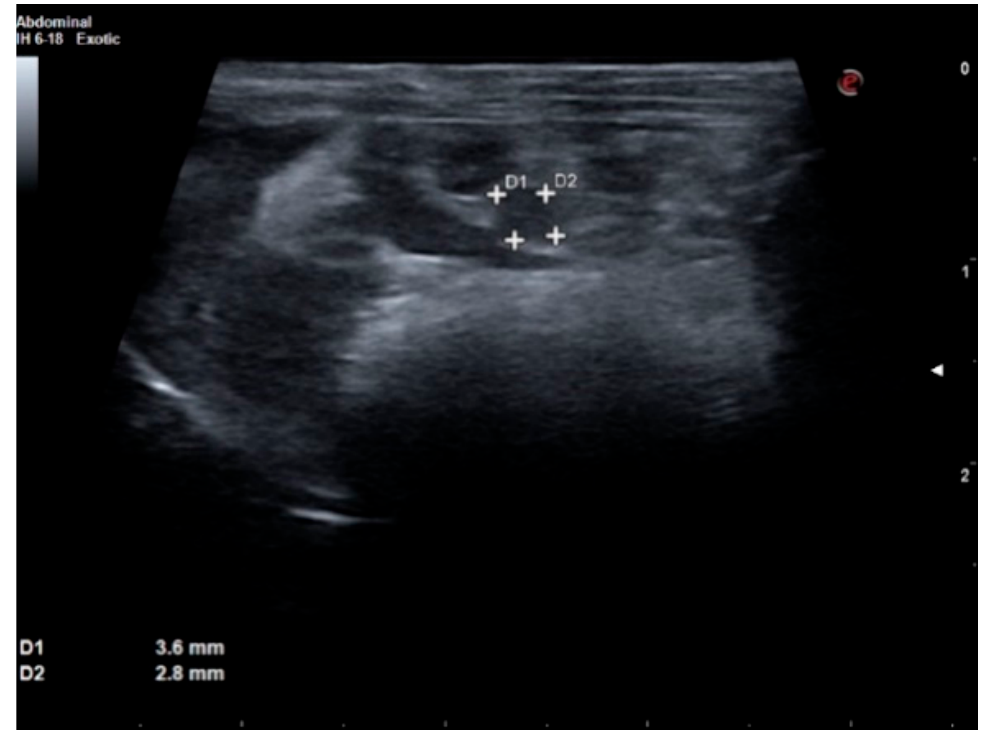
Figure 2. Ultrasound image of an insulinoma in the rat.